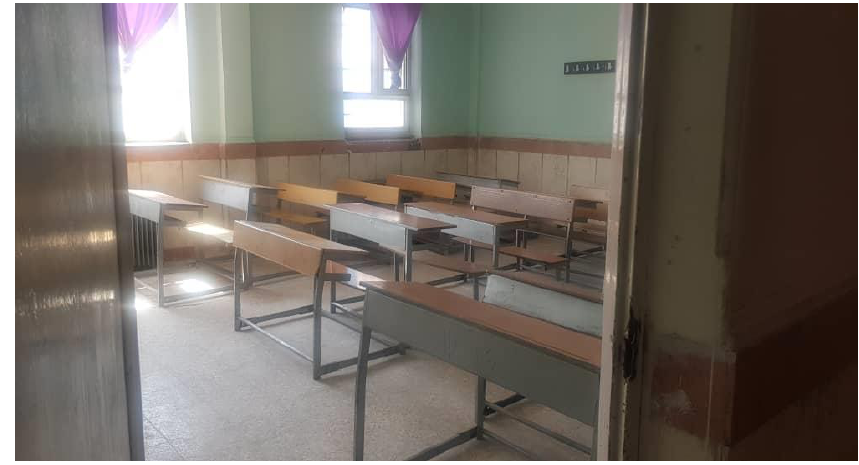
Figure 7. Classroom view.